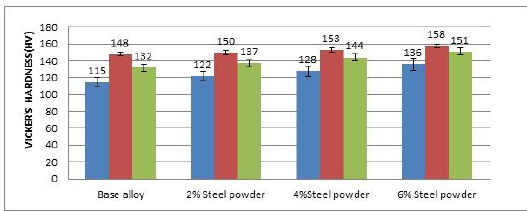
Figure 6. Peak hardness of conventional aged Al7075 eutectoid steel composite.